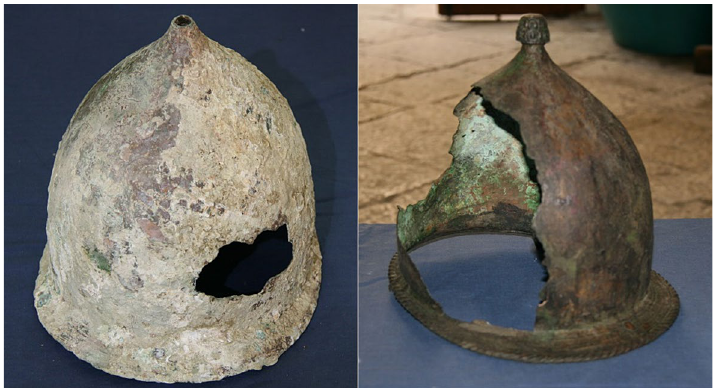
Figure 2. Example of Montefortino helmets recovered in the Egadi seabed after partial